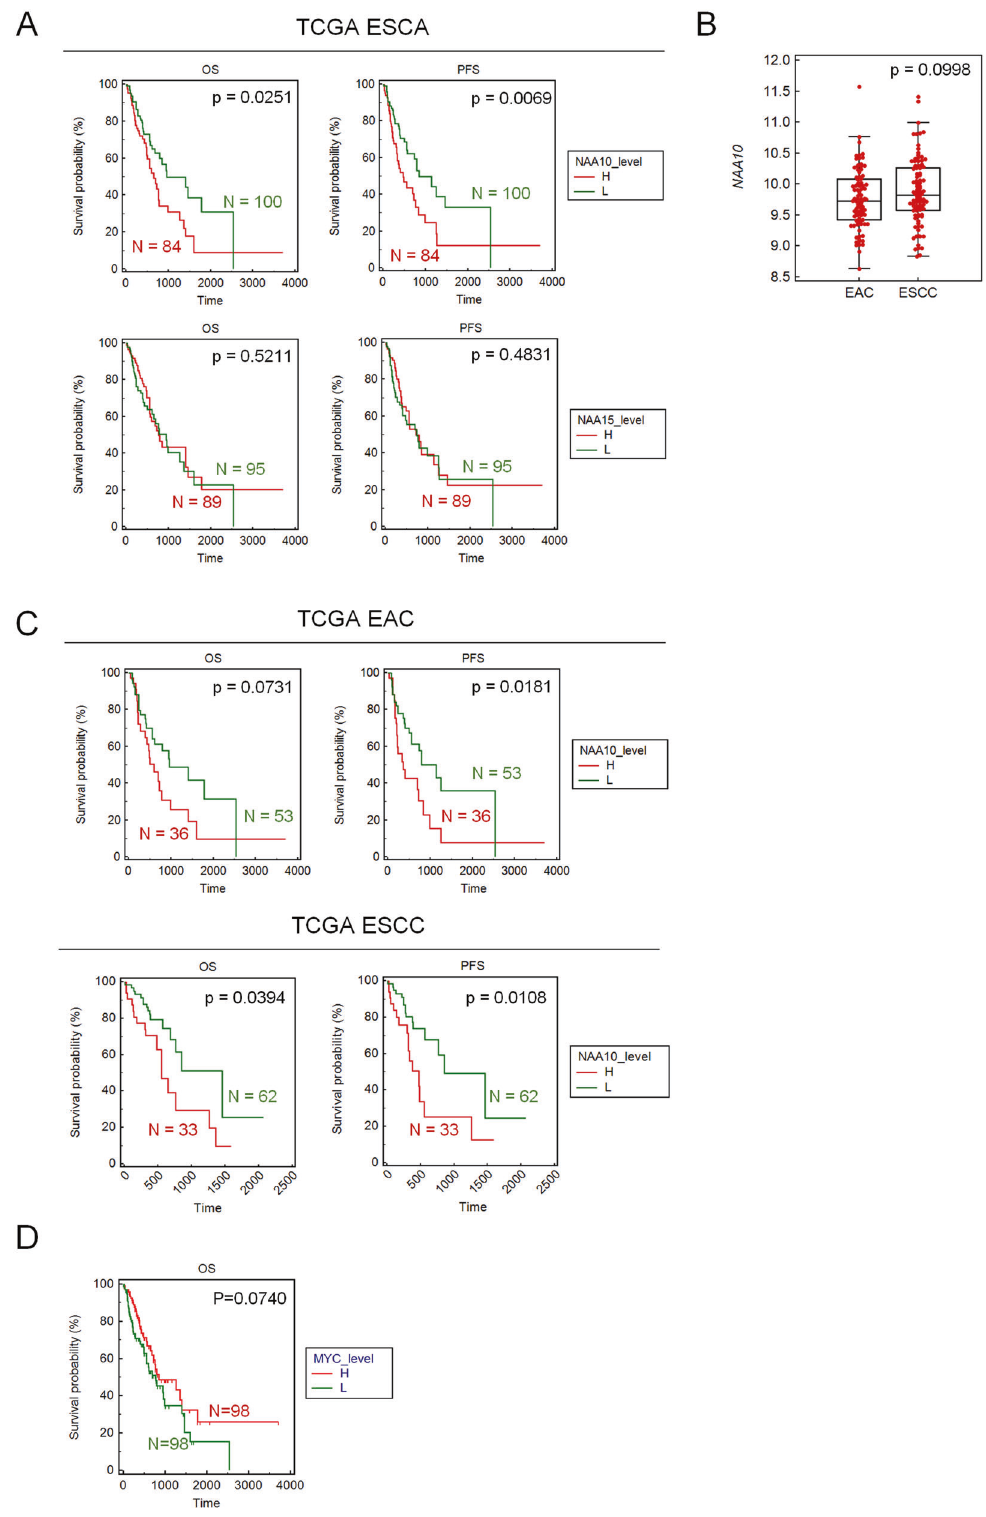
Fig. 3 NAA10 is a prognostic marker of ESCA. A Kaplan – Meier plot of overall (OS) and progress-free (PFS) survival of ESCA patients strati fi ed by NAA10 expression level. A log rank test was used to show differences between groups. B Comparison of the NAA10 expression level between EAC and ESCC. C Kaplan – Meier plot of OS and PFS survival of EAC or ESCC patients strati fi ed by NAA10 expression level. A log rank test was used to show differences between groups. D Kaplan – Meier plot of overall (OS) survival of ESCA patients strati fi ed by MYC expression level. A log rank test was used to show differences between